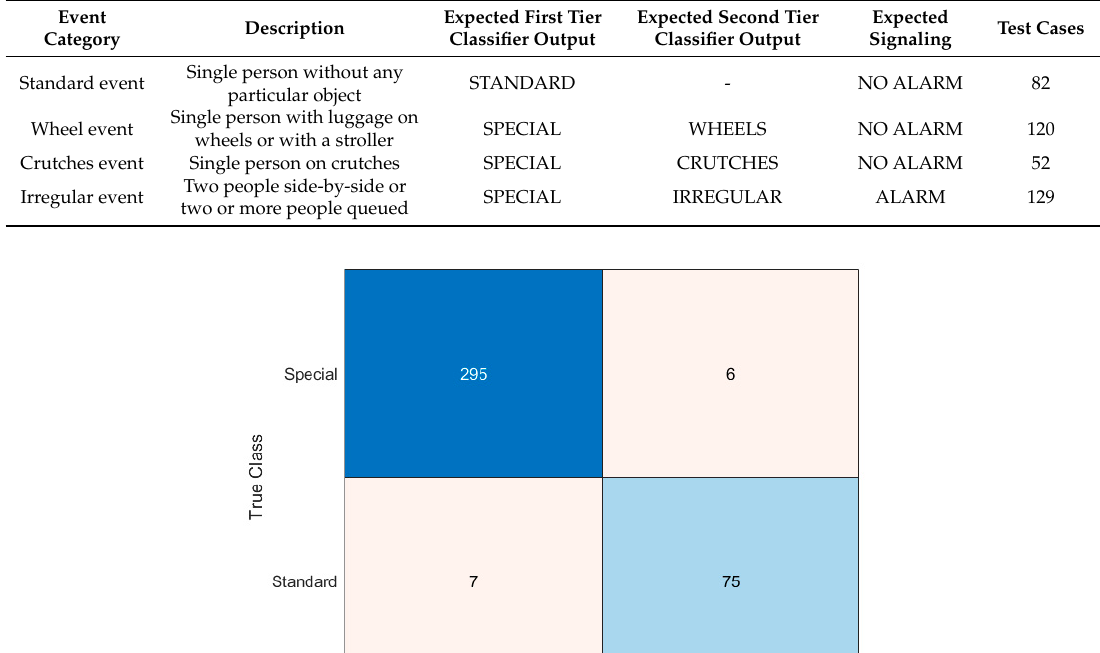
Table 1. Test cases and expected behavior of the classification algorithm.